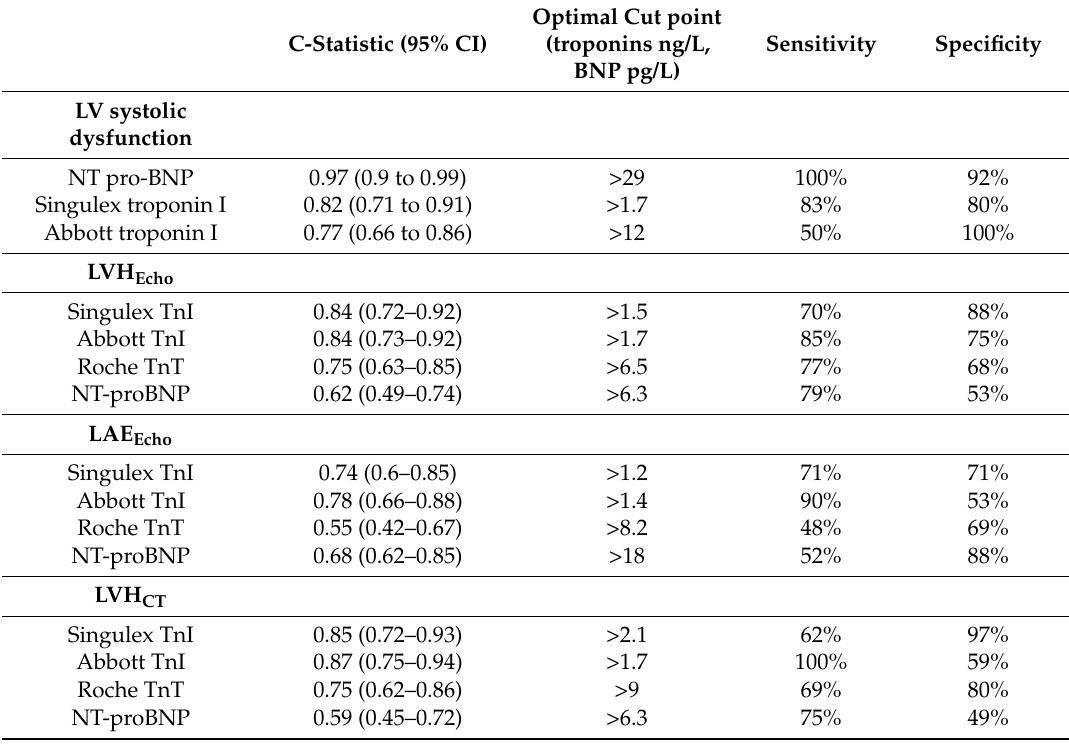
Table 2. Receiver-operative characteristics curve analysis of structural heart disease: figures are c-statistics (95% confidence interval (CI)).